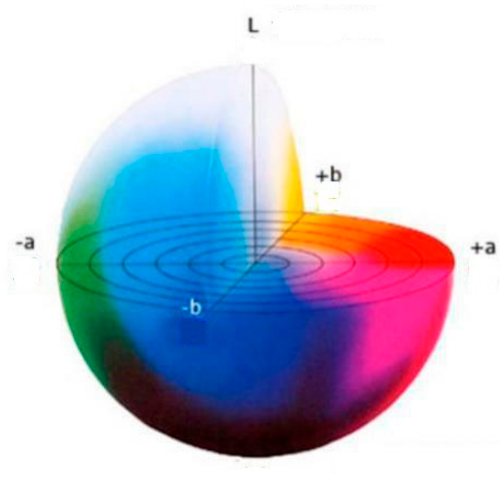
Figure 2. Sketch of a Lab color model.